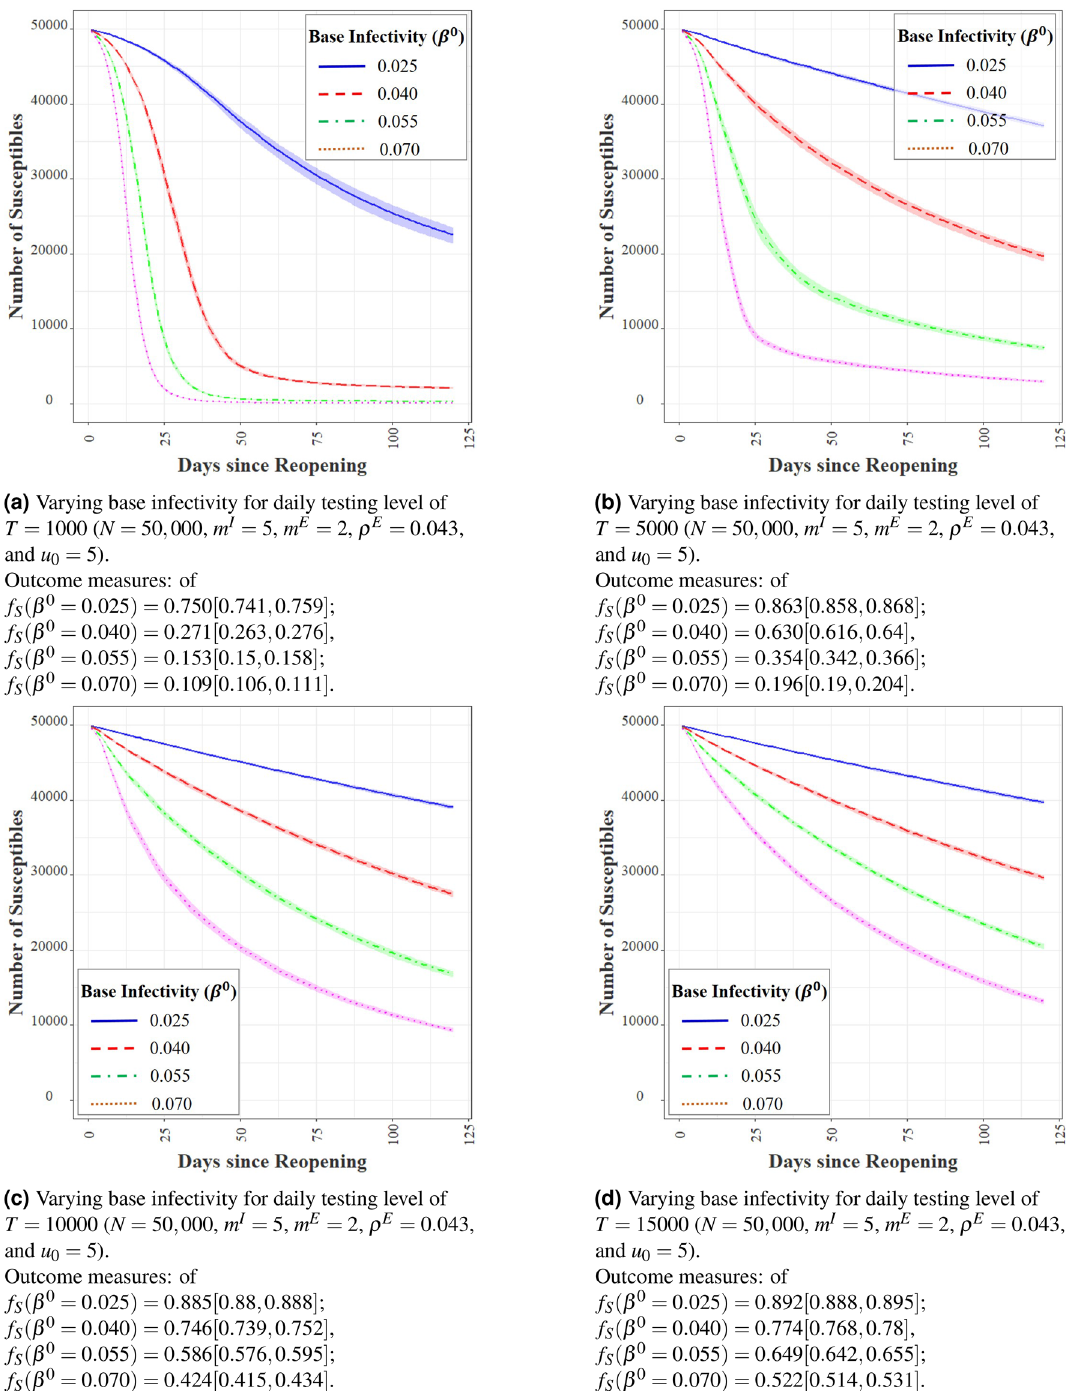
Figure 6. Effect of base infectivity rates on agent-based